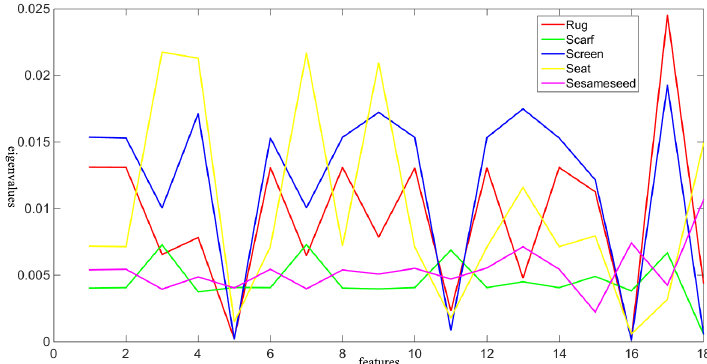
Figure 6. Difference of average eigenvalues between training and testing samples for Kylberg